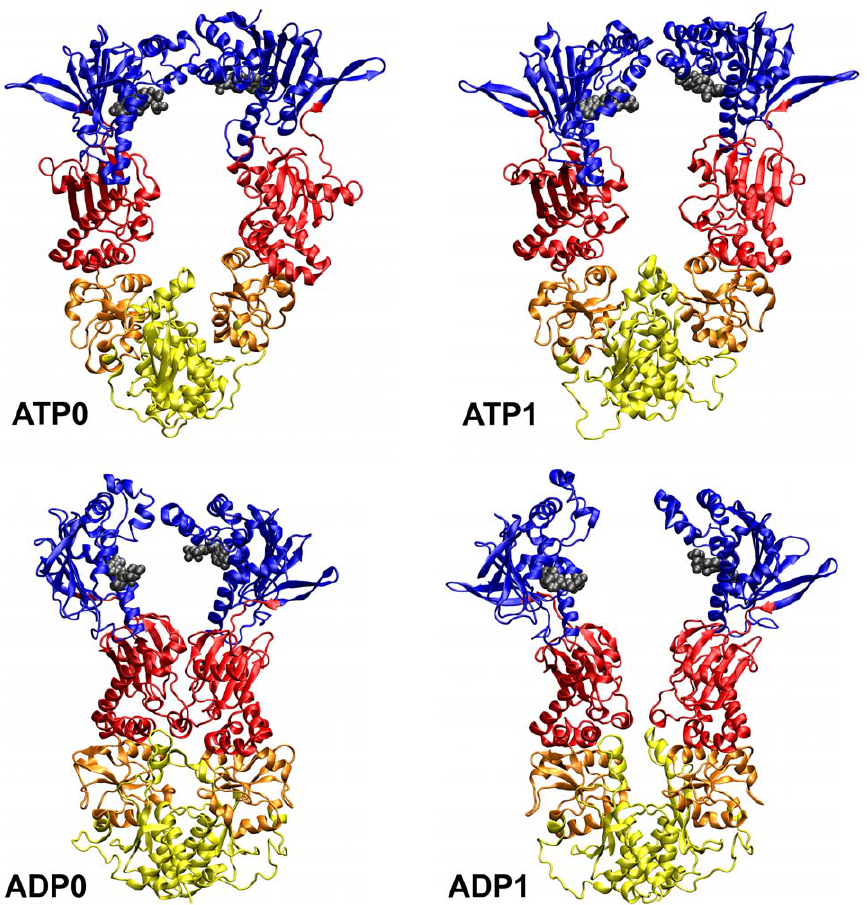
Figure 3. Representative structures of HtpG. Labels ATP0 and ATP1 show the representative structures of the two most populated clusters in the HtpG-ATP simulation. Labels ADP0 and ADP1 show the representative structures of the two most populated clusters in the HtpG-ADP simulation.